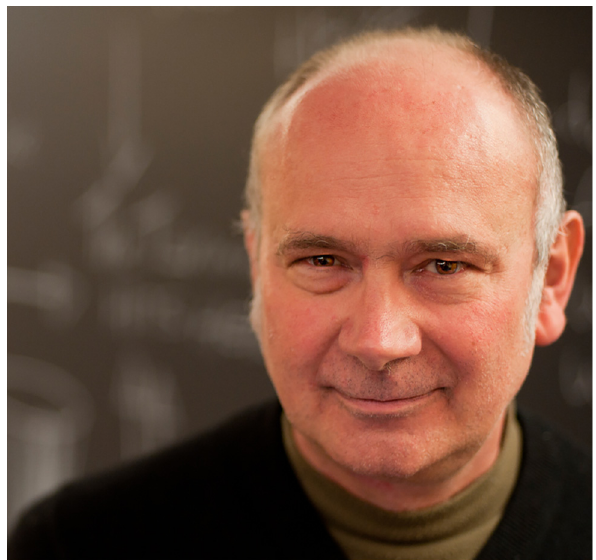
Fig 2. Winston (Win) Hide. Professor of Computational Biology and Bioinformatics, Sheffield Institute for Translational Neuroscience, the University of Sheffield, United